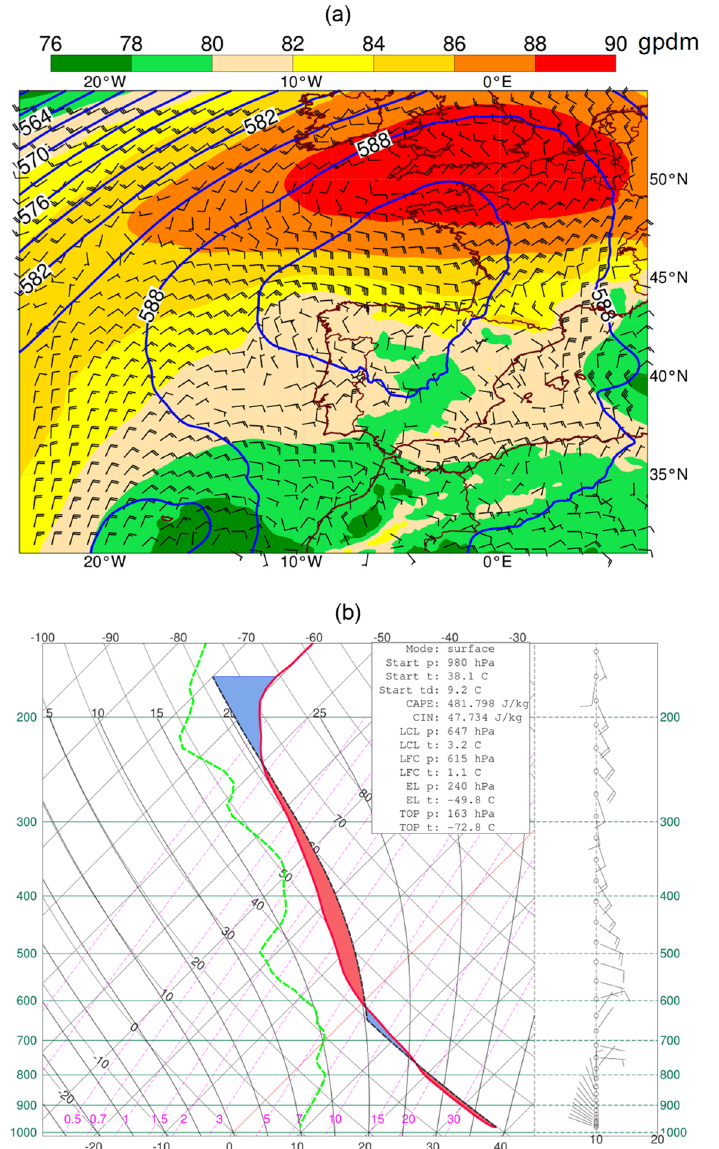
Figure 9. ( a ) ECMWF analyses of geopotential height (in gpdm) at 500 hPa (contours) and 925 hPa (shading), along with the 925 hPa winds, on 17 June 2017 at 18:00 UTC. ( b ) The skew-T Log-P diagram at WS 570 (Castelo Branco), based on ECMWF analysis on 17 June 2017 at 12:00 UTC. The air temperature (red line), dewpoint temperature (green dashed line), and parcel trajectory (black dashed line) are plotted. The positive buoyancy (red) and negative buoyancy (blue) areas are also plotted. The forecasts of the numerical weather prediction model, “Application of Research to Operations at Mesoscale”, AROME [47], valid for 18:00 UTC, reveal two cores of high SLP (>1014 hPa) slightly to the north of WS 570, where the wind gust displays a divergent pattern (Figure 10a), with maximum values exceeding 22.5 m s − 1 (45 kt), thereby representing a clear signature consistent with two mesohighs. Other mesohighs are also visible over Spain and near WS 571 (Portalegre), this being the last one in a dissipative stage. The